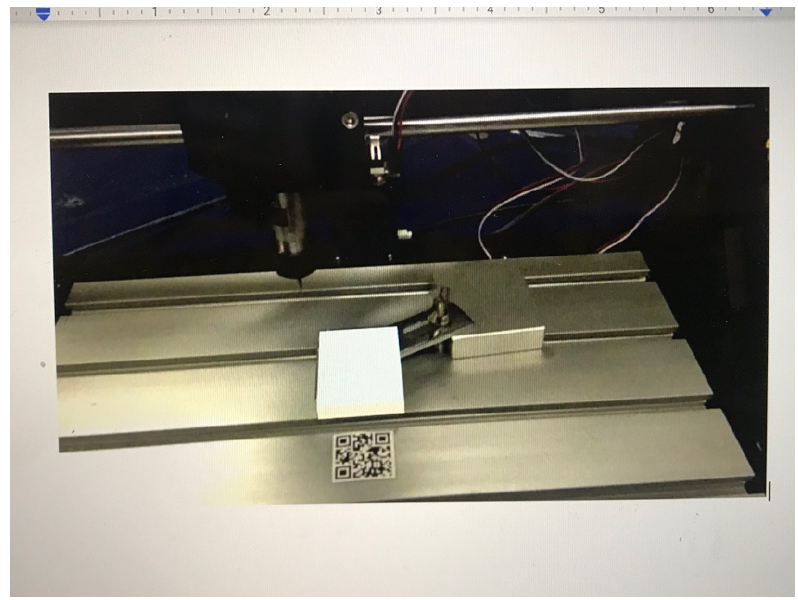
Figure 8. Image of Mixed Reality Block—representing the block model superimposed over the real-world workpiece.